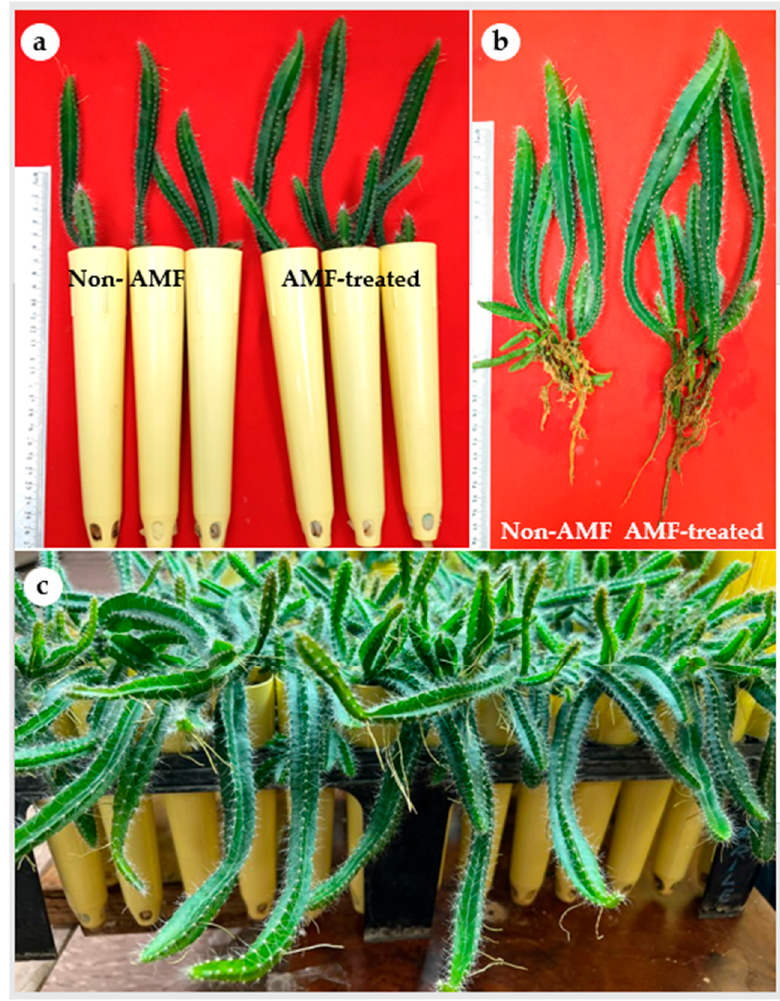
Figure 4. Influence of arbuscular mycorrhizal fungi on growth of H. polyrhizus after 8 weeks of acclimatization. ( a ) Non-AMF plantlets and AMF-treated plantlets grown in pots filled with sterile sand and soil (1:1; v/v ), ( b ) root growth of non-AMF plantlets and AMF-treated plantlets and ( c ) micropropagated plantlets after 12 weeks of acclimatization.